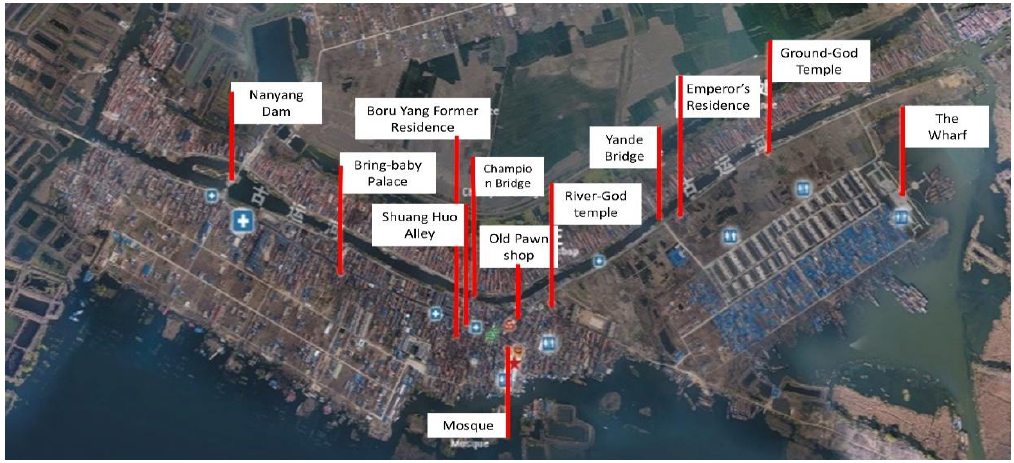
Figure 2. Aerial view map of Nanyang.